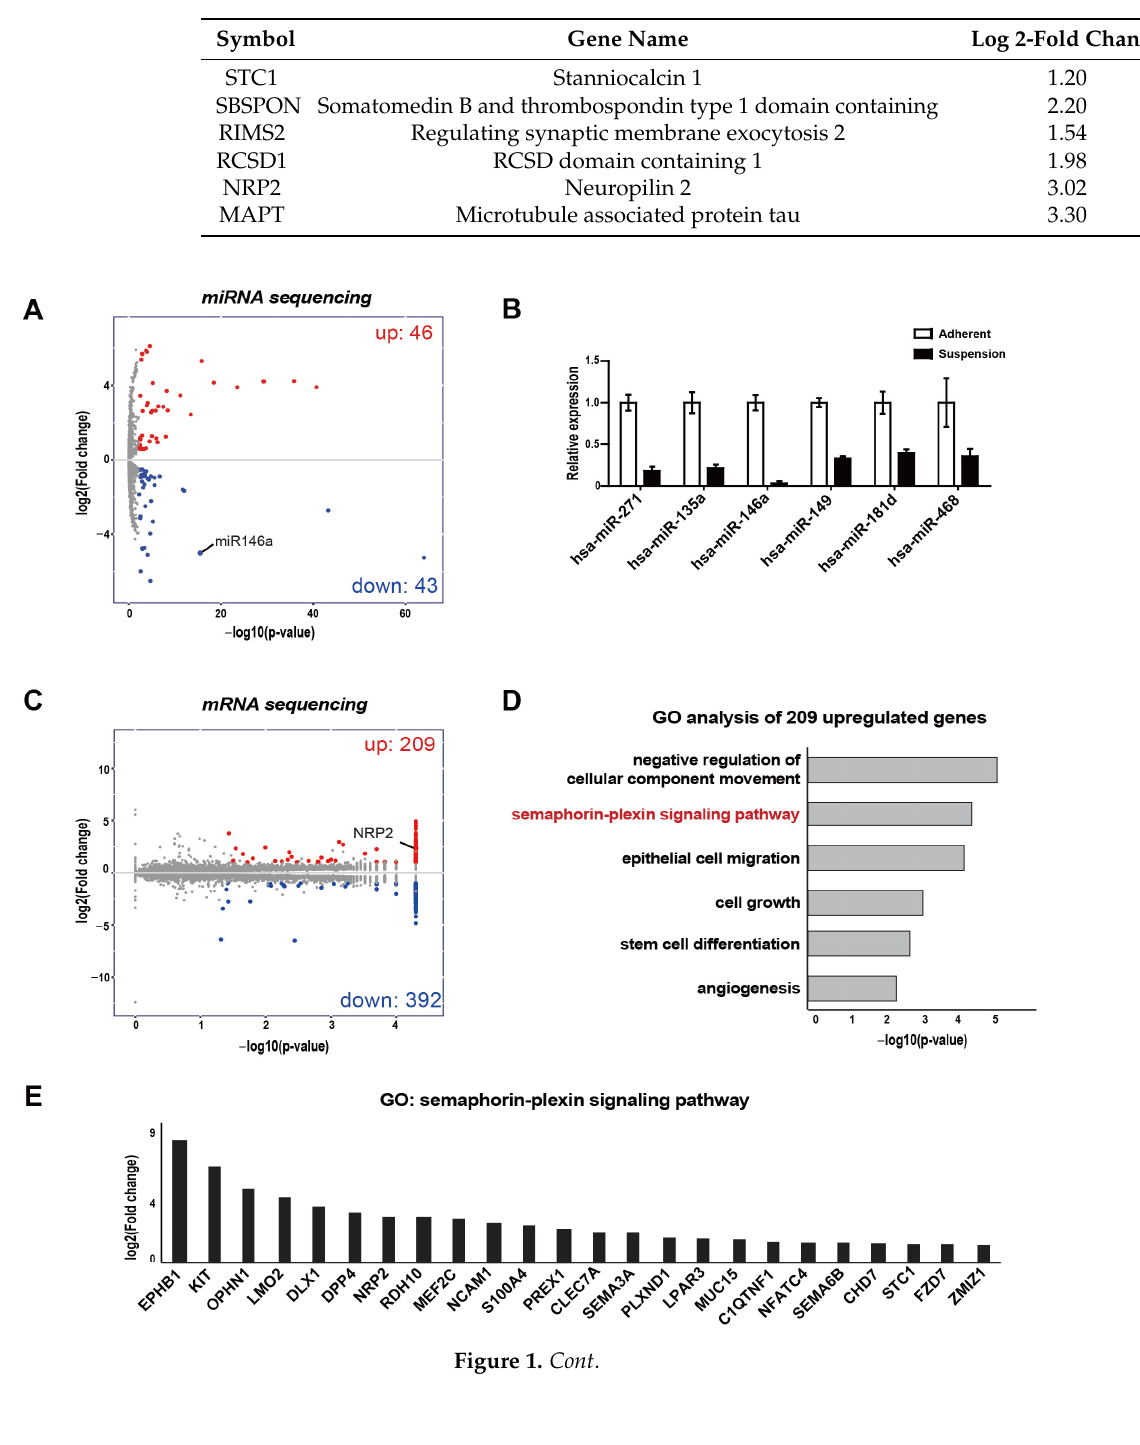
Table 2. Predicted targets of upregulated miR-146a in MDA-MB-468 suspension cells.